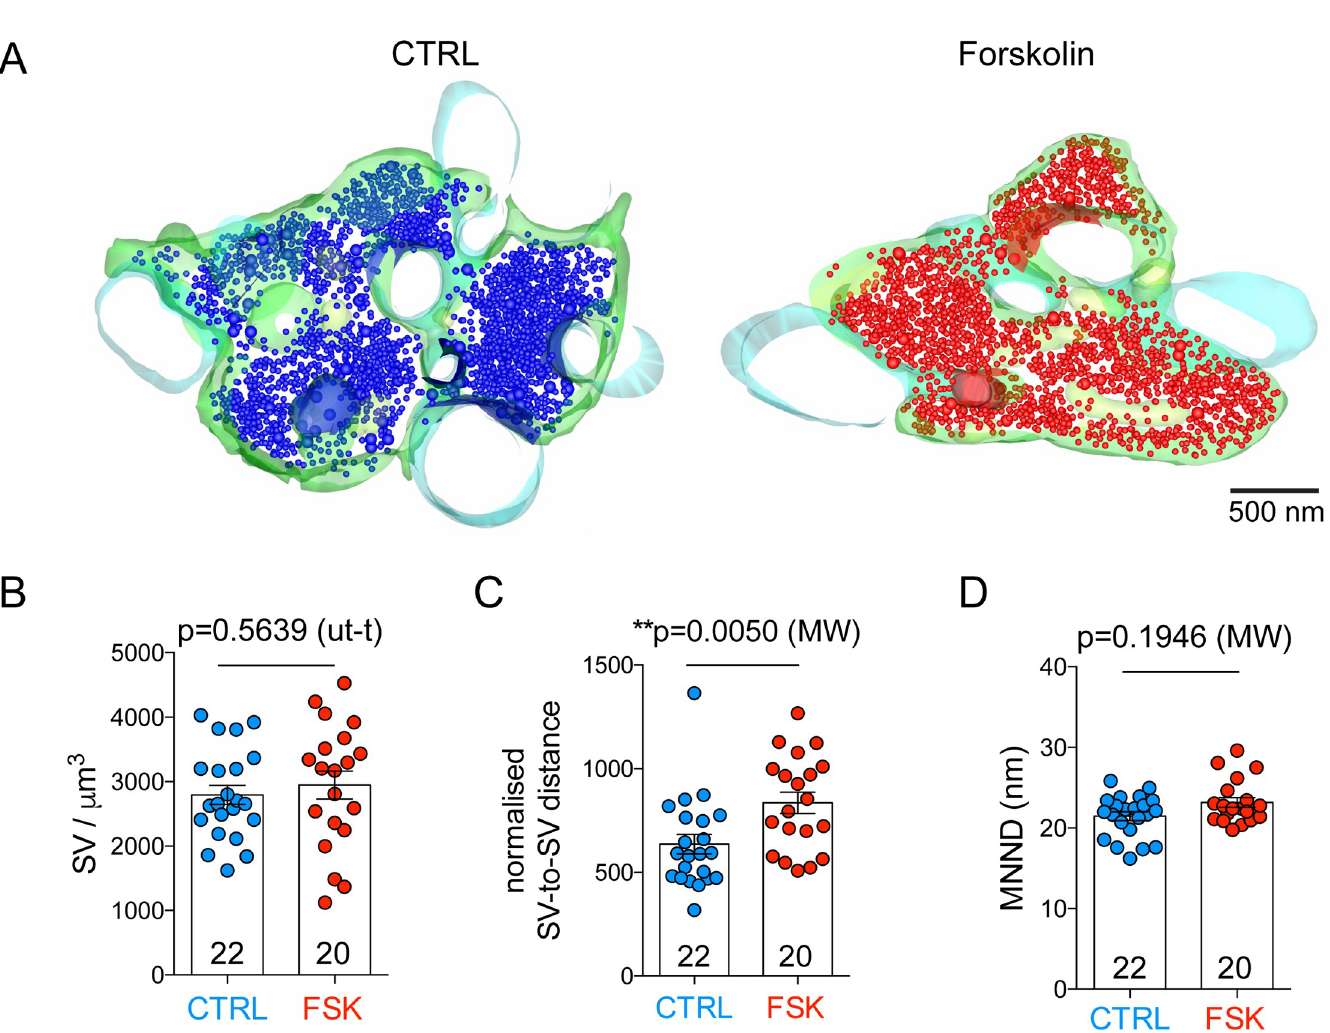
Fig 5. SVs disperse upon forskolin-induced presynaptic potentiation in cryo-fixed acute slices. (A) Partial 3D reconstruction of hippocampal mossy fiber boutons in control conditions or after forskolin treatment. Presynaptic membrane is green, postsynaptic membrane is light blue, and SVs are blue (control) or red (forskolin). (B) Bar graphs indicating the quantification of SV density per cubic micron of reconstructed volume; SV density was comparable in forskolin-treated and control terminals ( p = 0.5639, unpaired t test). (C) Bar graphs indicating the quantification of SV distance from other SVs normalized by the volume of the reconstruction (nm/ μ m 3 ); distance between vesicles was increased in forskolin-treated terminals ( p = 0.0050, Mann–Whitney U test). (D) Bar graphs indicating the quantification of MNND between vesicles (nm); MNND was comparable in forskolin-treated and control terminals ( p = 0.1946, Mann–Whitney U test). In all graphs, scatter points indicate individual boutons, n = 22 boutons for control and 20 boutons for forskolin-treated slices from 4 animals. Values represent mean ± SEM. CTRL, control; FSK, forskolin; MNND, mean nearest neighbor distance; MW, Mann–Whitney U test; SV, synaptic vesicle; ut-t, unpaired t test. The data underlying this figure can be found at doi: 10. 5281/zenodo.4498214.